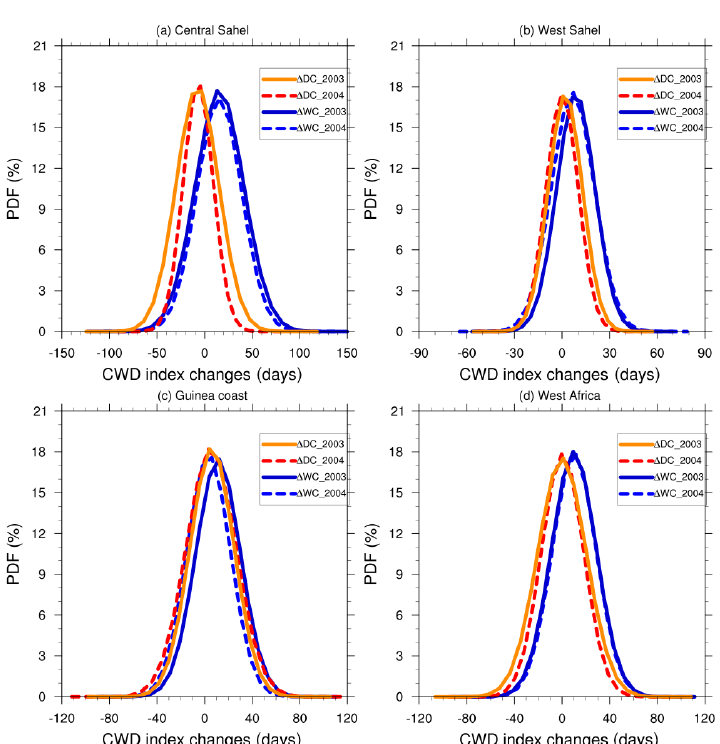
Figure 8. Same as Fig. 2 but for the CWD index (in days).